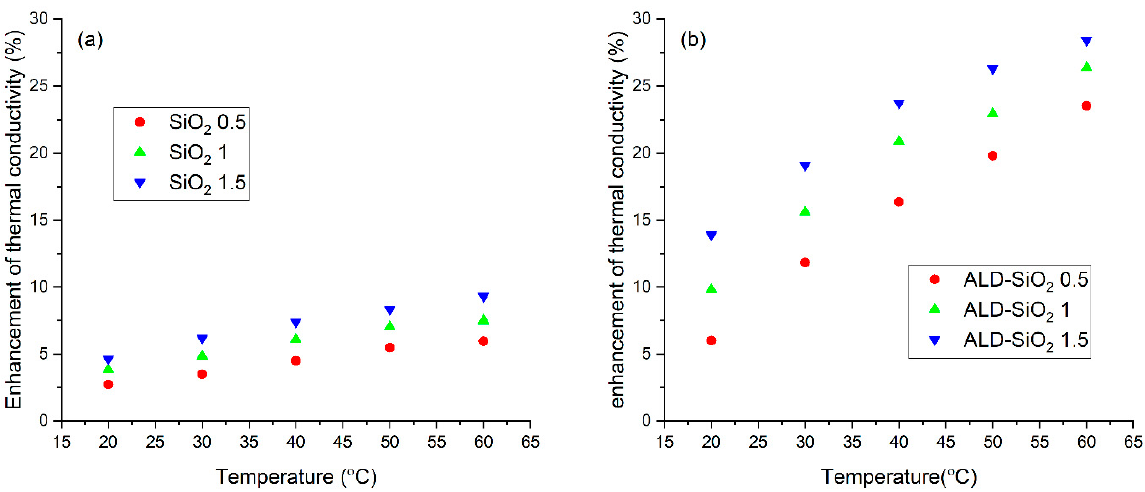
Figure 9. Enhancement of thermal conductivity of the SiO 2 ( a ) and composite ( b ) nanofluids.